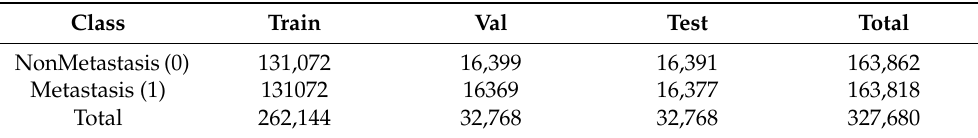
Table 1. The number of images in PCam dataset and their partitioning for training, validation, and testing. It is clear that this is a balanced